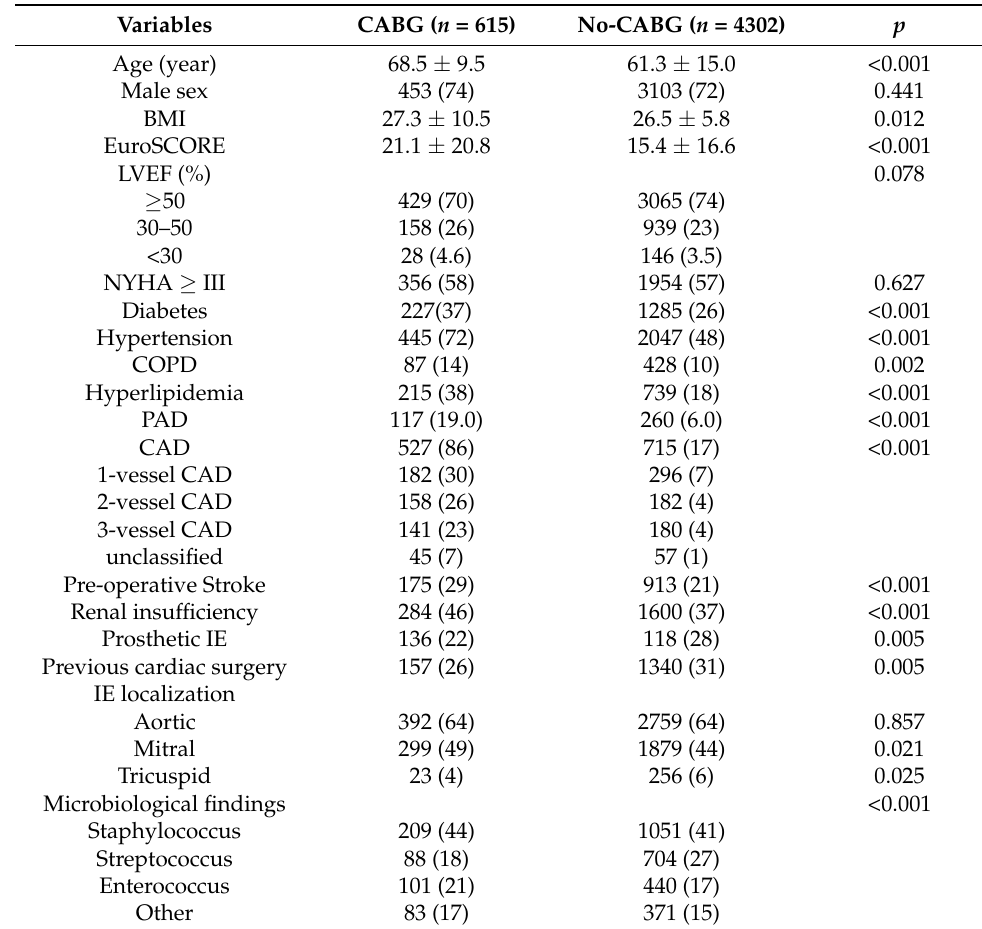
Table 1. Baseline characteristics of all patients divided into patients who received CABG and those who did not receive